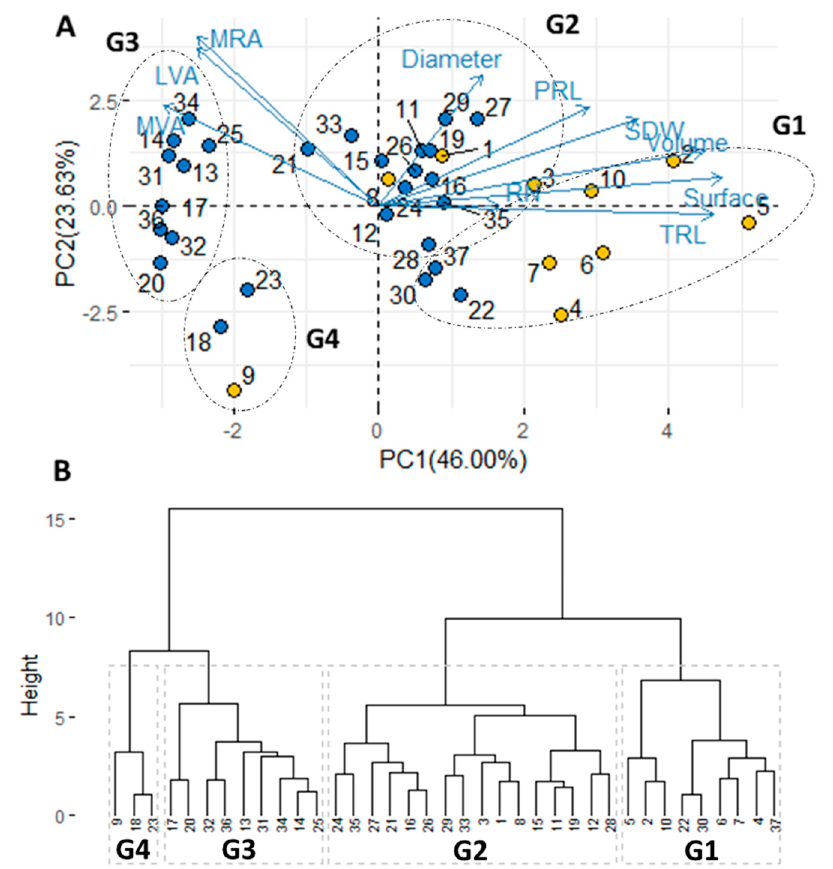
Figure 3. Biplot of the first two principal components ( A ) and dendrogram resulting from hierarchical clustering ( B ) based on seedling traits for 37 durum wheat genotypes. Ellipses in ( A ) encompass the individuals according to the clustering presented in ( B ). Yellow symbols correspond to landraces; blue symbols correspond to cultivars. Genotypes coded with numbers as in Table 1.